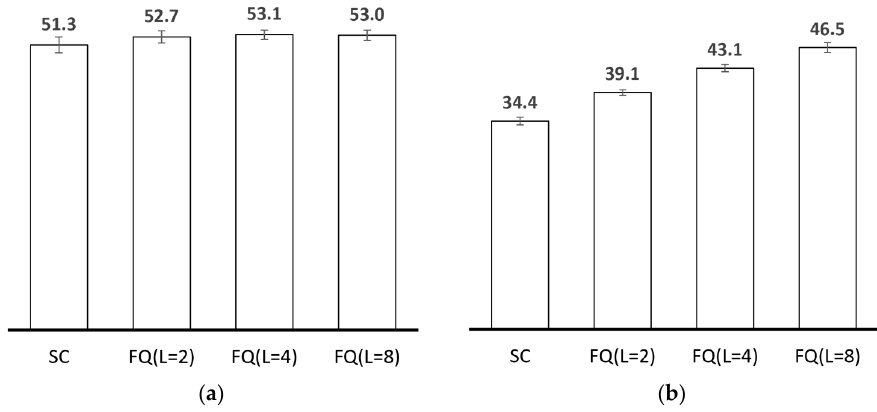
Figure 4. Results when PRoPHET utilizes single-copy replication (SC) and fixed-quota replication (FQ) under the large scenario: ( a ) without external messages ( b ) in the presence of external messages, i.e., messages generated by other applications and routed using PRoPHET without a replication technique (for external messages, a randomly selected source node generates a message between 10 KB and 100 KB to a randomly selected destination node at every 1 to 5 min interval).